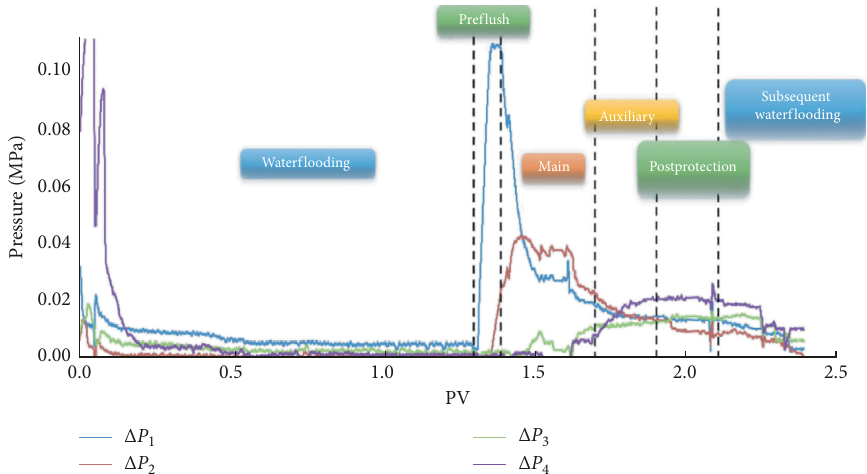
Figure 14: Sectional pressure differences.